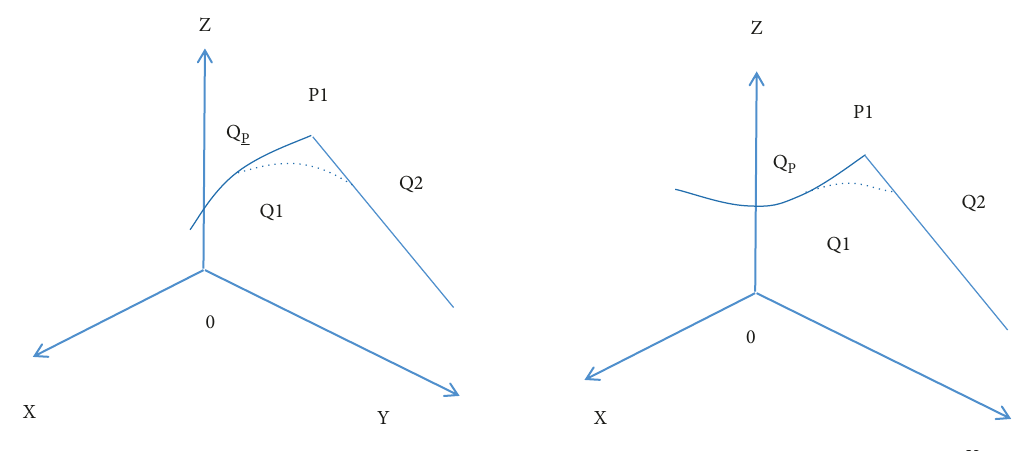
Figure 6: Schematic diagram of the transition between the arc and straight line.